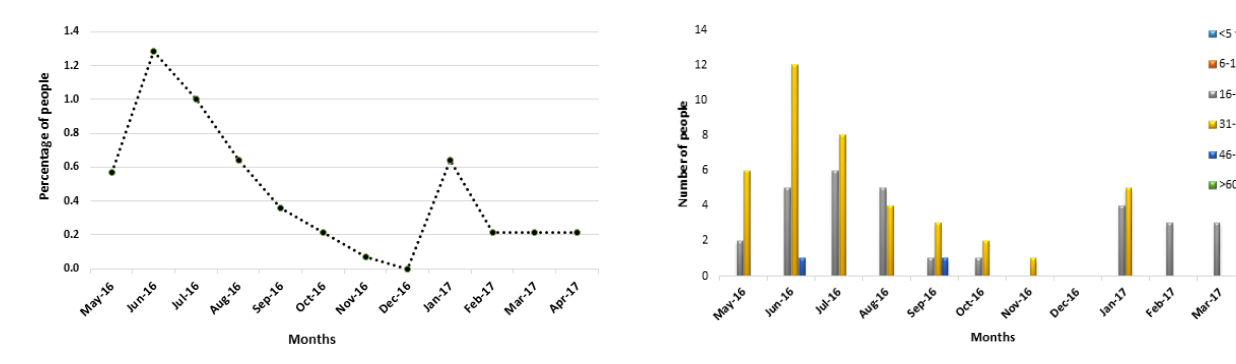
Figure 2 . Monthly Movement of People (in Percentages) to Malarious Areas (OS- N) for a Period of 1 Year.